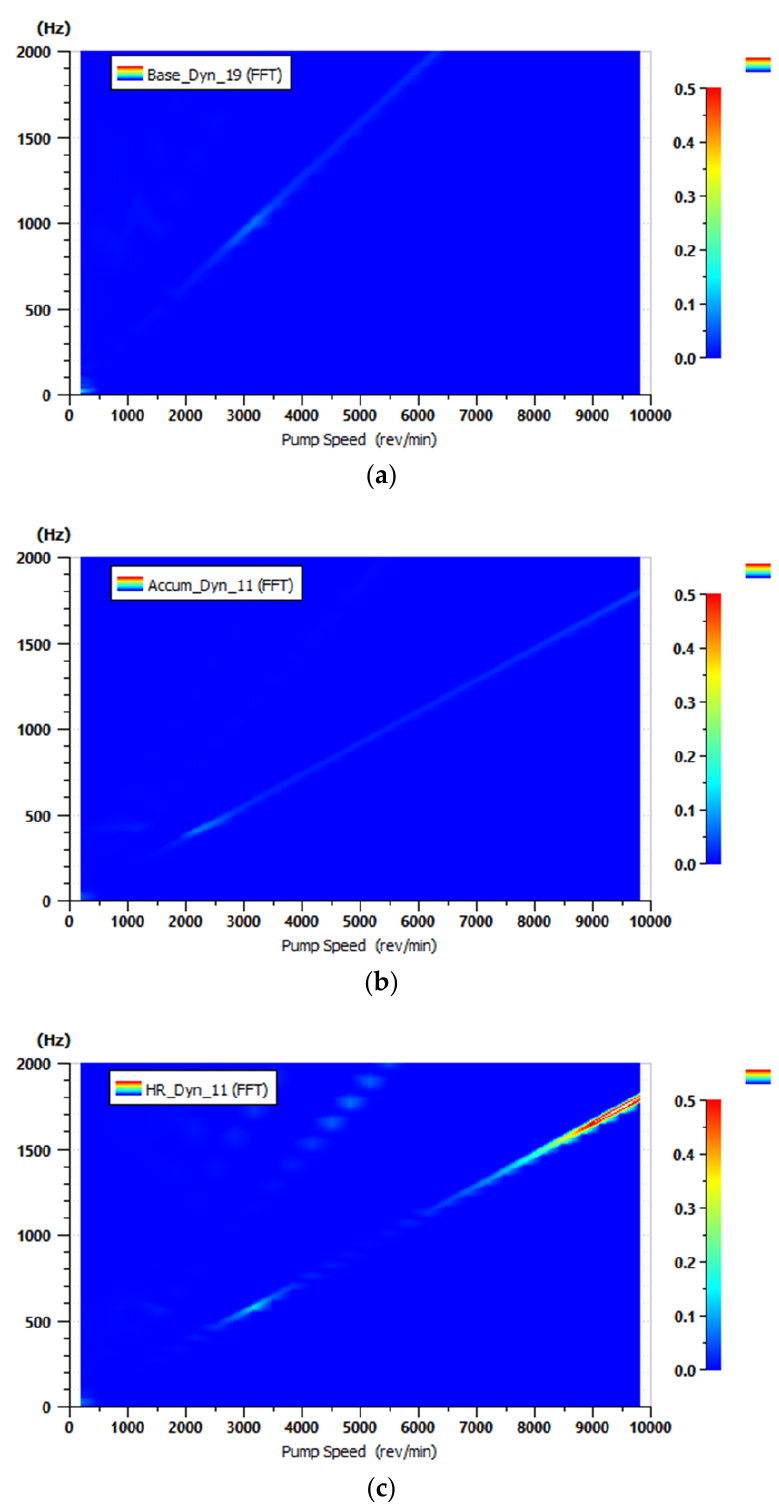
Figure 12. Spectral maps of: ( a ) Base_Dyn_19; ( b ) Accum_Dyn_11; ( c ) HR_Dyn_11.